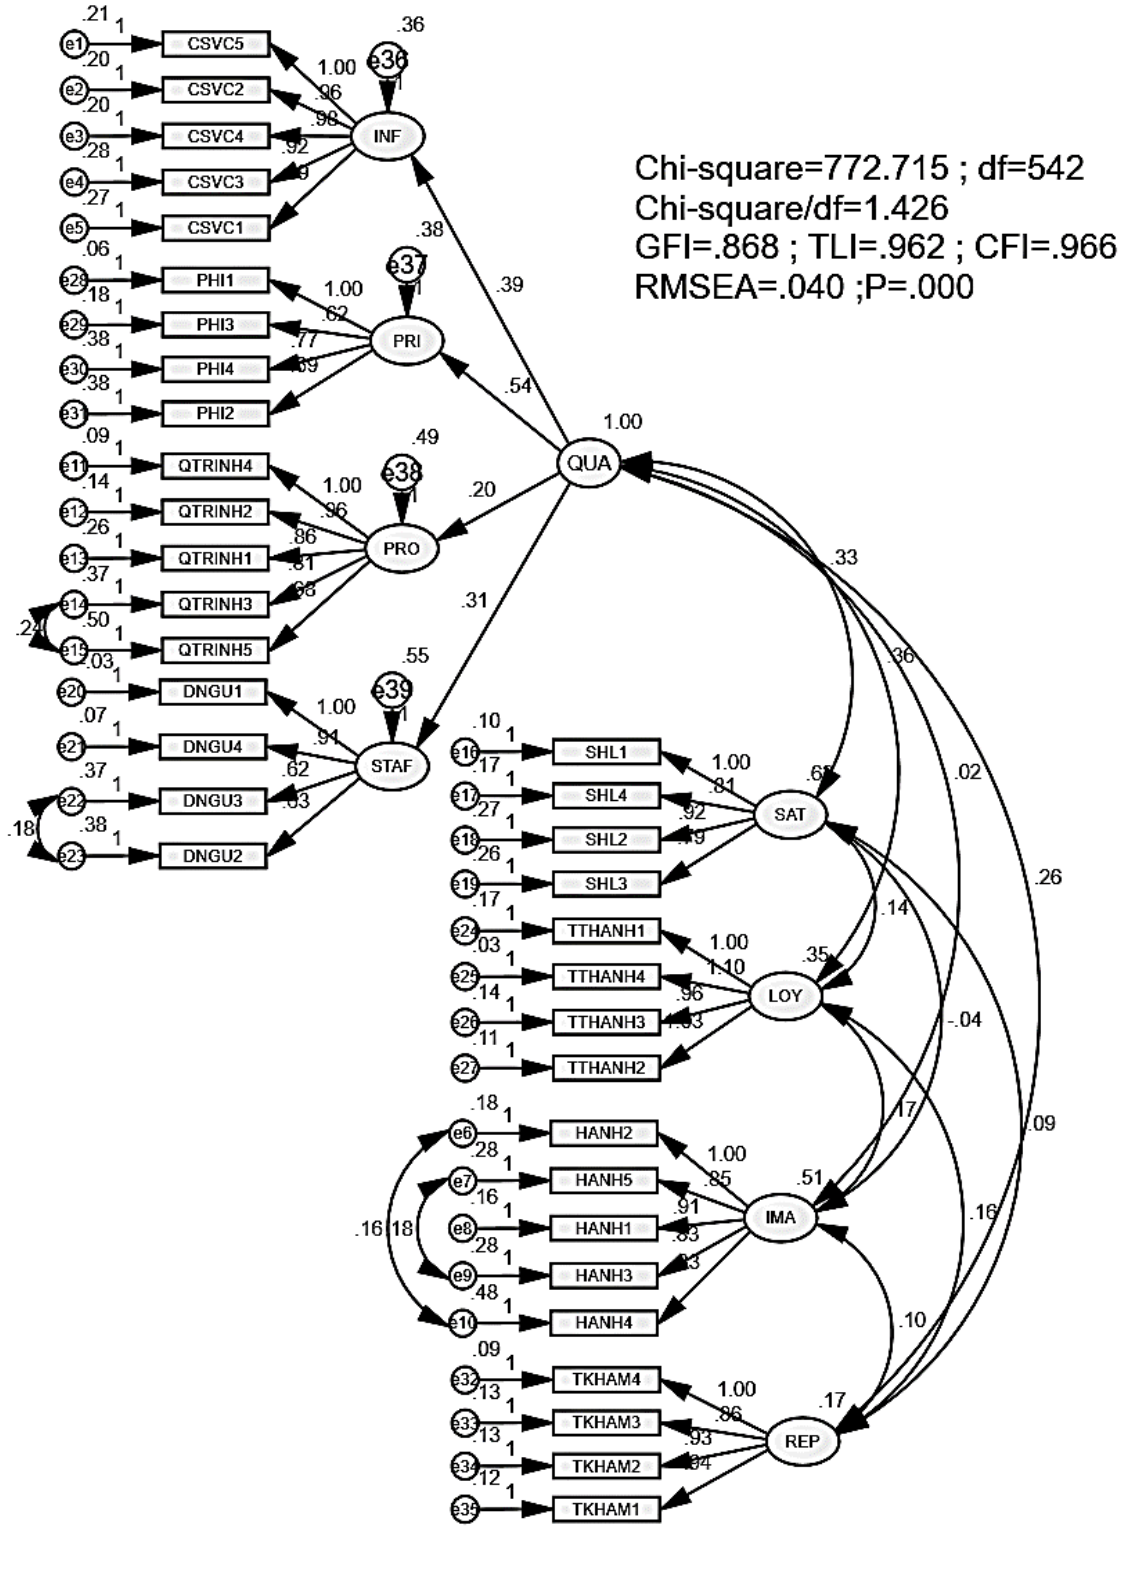
Figure 2. Standardized CFA